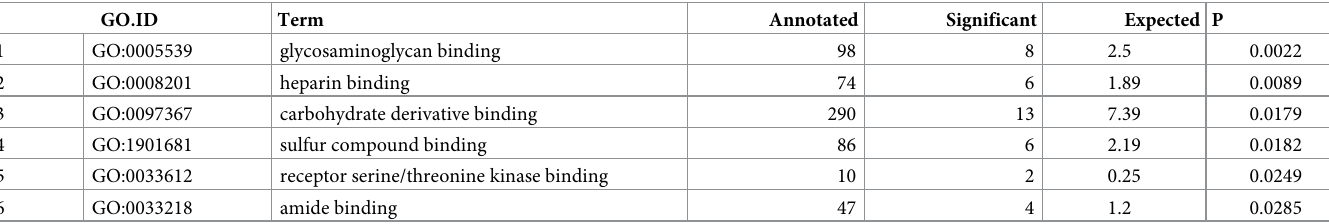
Table 2. GO enrichment of the top 30 important genes/proteins in the COPD ConvGNN model.